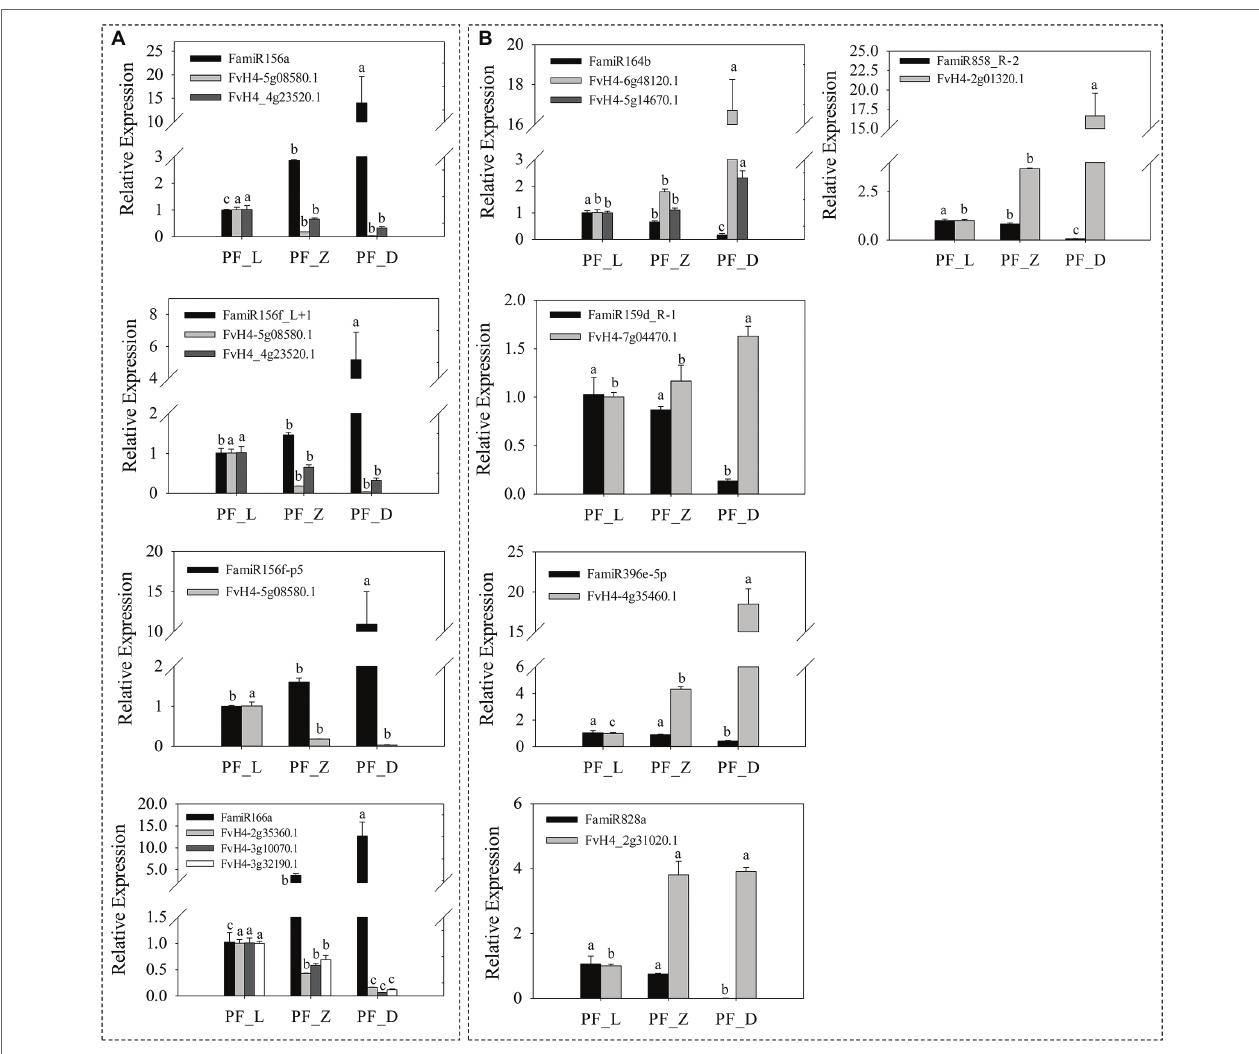
FIGURE 5 | Expression patterns of nine anthocyanin-related miRNAs and corresponding candidate targets in pink-flowered strawberry. (A) The expressions of miRNAs showed an upward trend, while their corresponding targets showed a downward trend during flower development. (B) The expression levels of miRNAs decreased gradually, while the expression levels of corresponding targets increased gradually. L, young bud stage; Z, beginning coloration stage; and D, big bud stage. Error bars show the SEs from three biological replicates and the lowercase indicates statistical significance at p <